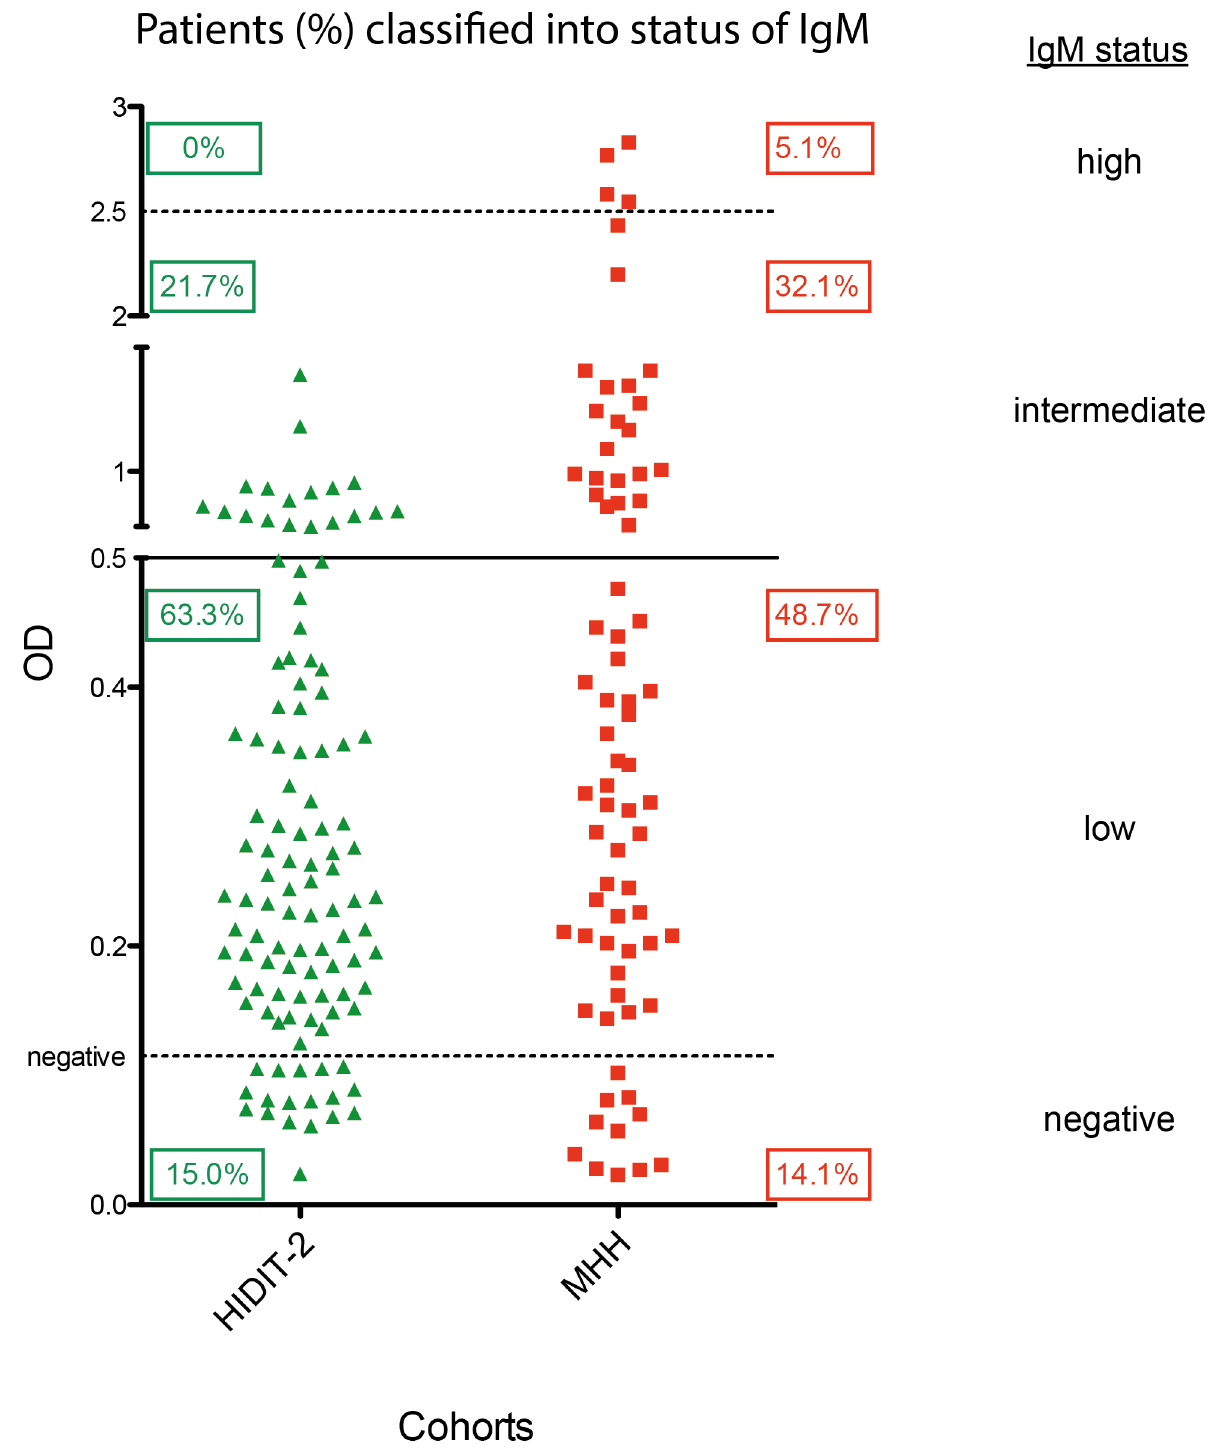
Figure 1. Anti-HDV IgM values in the two cohorts. Grouping into different IgM categories was performed as descripted in materials and methods.